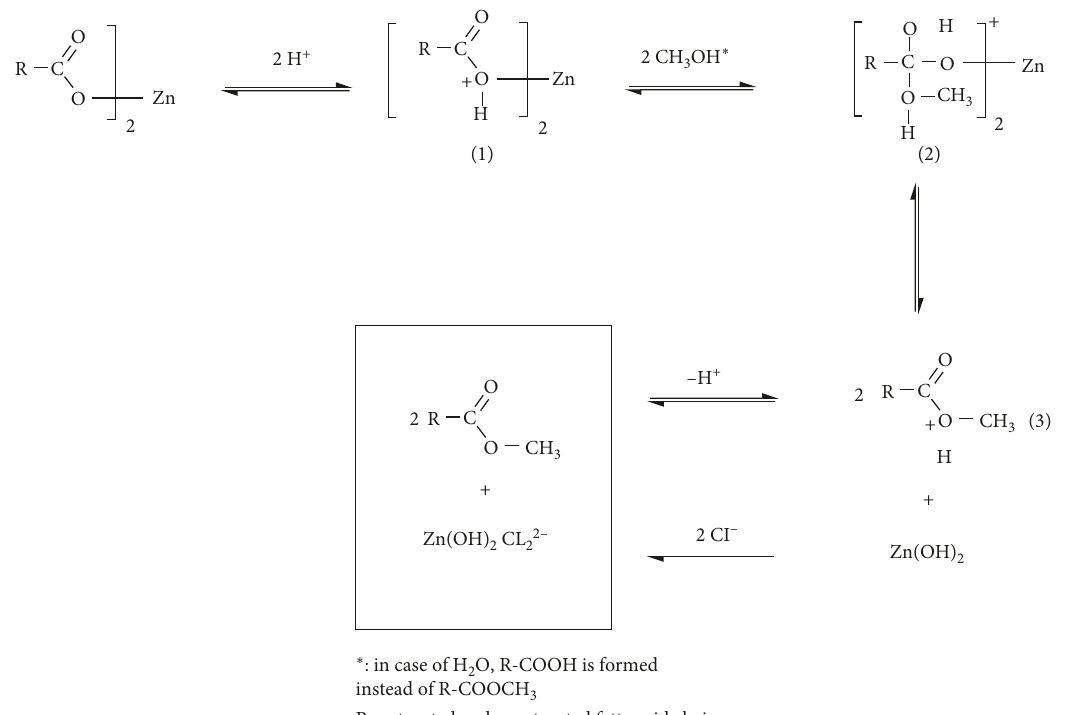
Figure 7: Proposed mechanism for formation of fatty acid methyl esters from fatty acid zinc